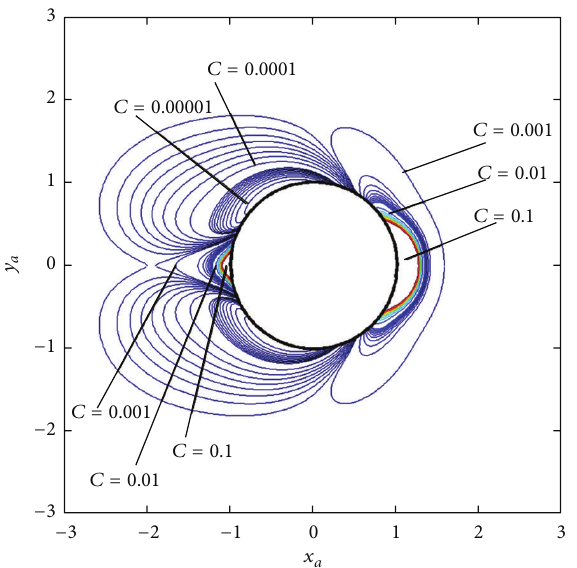
Figure 6: The concentration contours of Mn 2 P 2 O 7 ⋅ 3H 2 O nanopar- ticles of 24 nm diameter at 𝑡 = 34.12